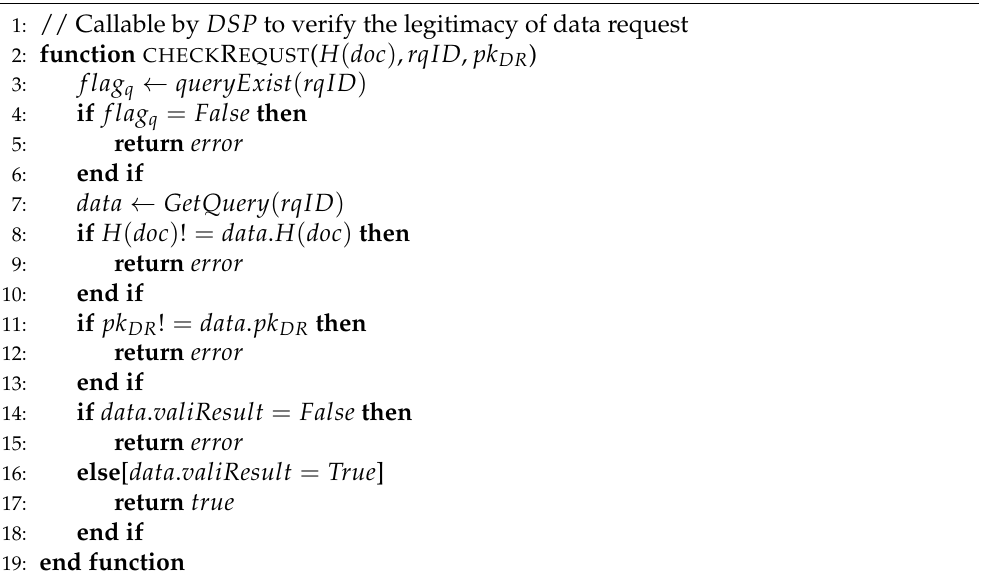
Algorithm 4 DSC.checkRequst